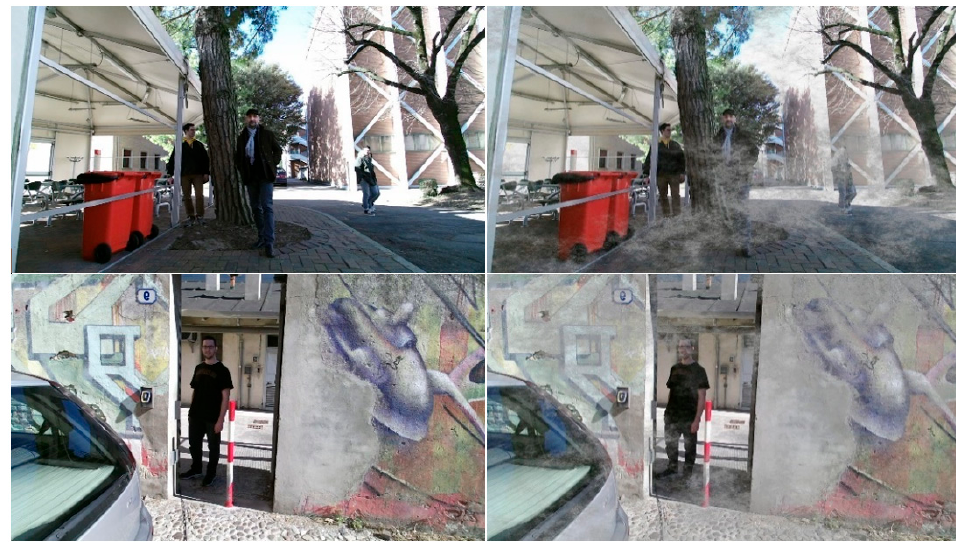
Figure 6. Original images ( left ), fog-perturbed images ( right ).